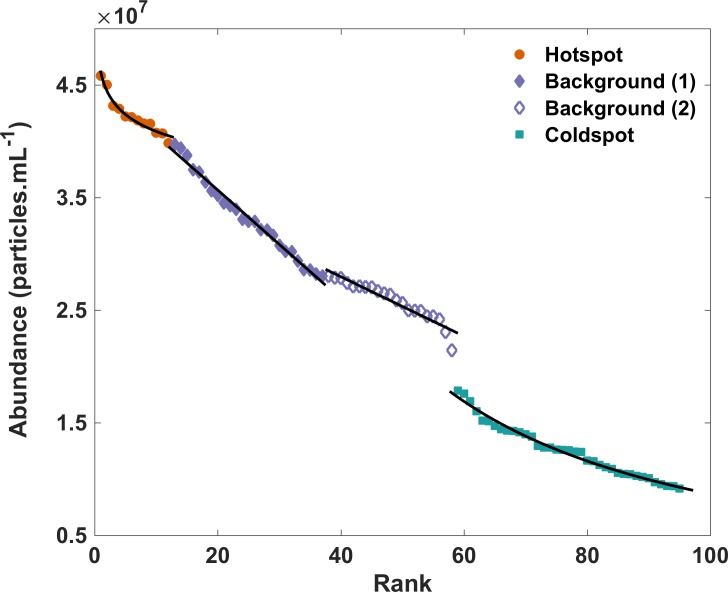
Rank abundance plot showing breaks and fitted distributions for hotspots (power), background (linear) and coldspots (power).